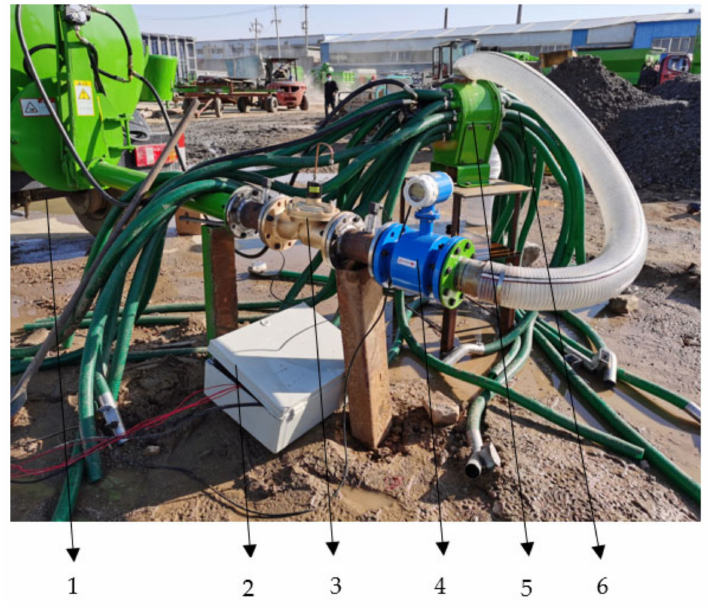
Figure 16. Test platform. 1: pump; 2: monitoring and control via computer; 3: electric proportional valve; 4: flow meter; 5: distributor; 6: sprinkler